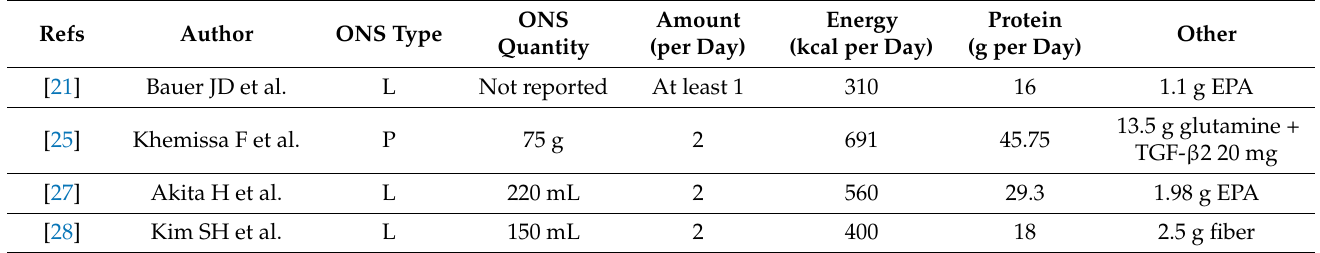
Table 2. Main characteristics of Oral Nutritional Supplements used in the enrolled studies.